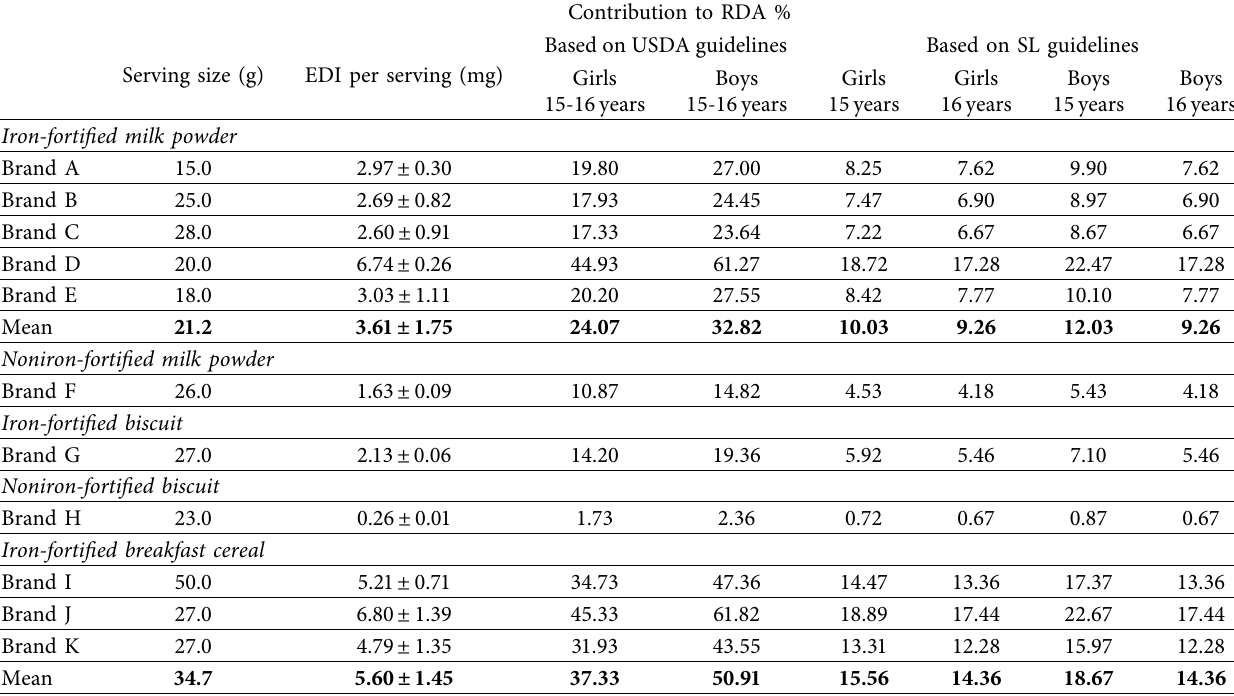
Table 4: Estimated daily intake of iron per serving of each food item and their contribution to